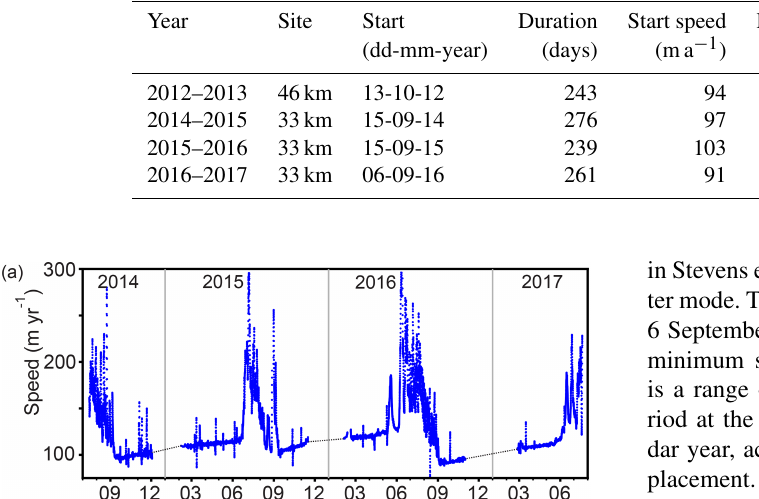
Table 1. Characteristics of winter acceleration as measured with GPS stations.